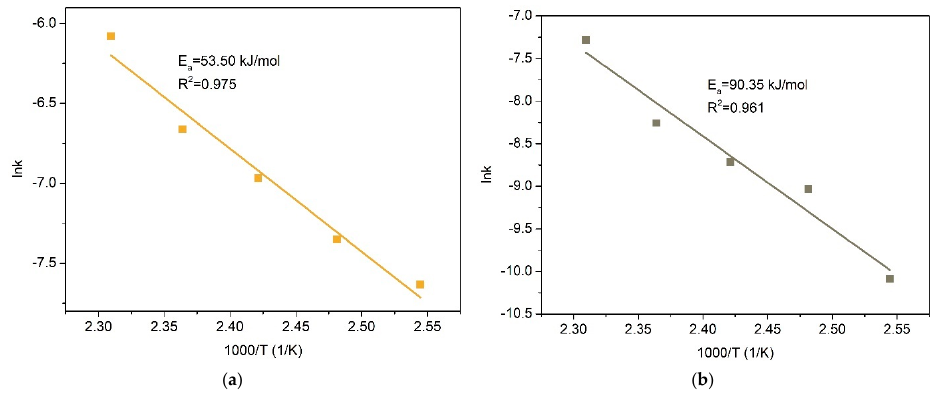
Figure 4. Dependence of lnk-1000/T for the recovery of copper ( a ) and silver ( b ) into solution.